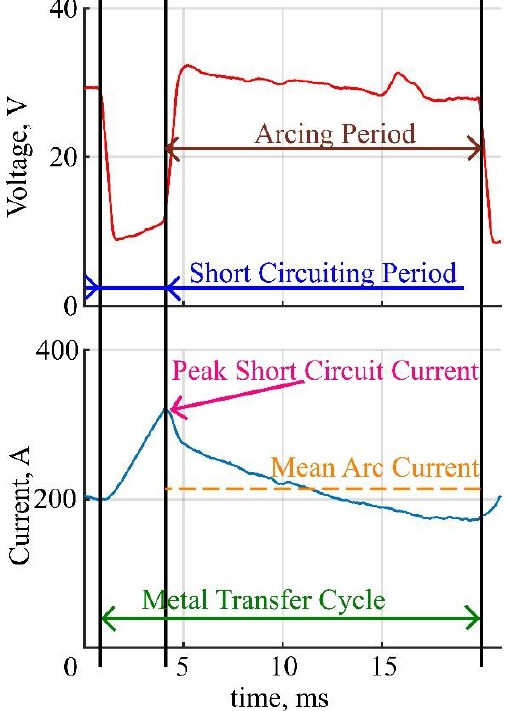
Figure 1. Graphical representation of measured parameters.